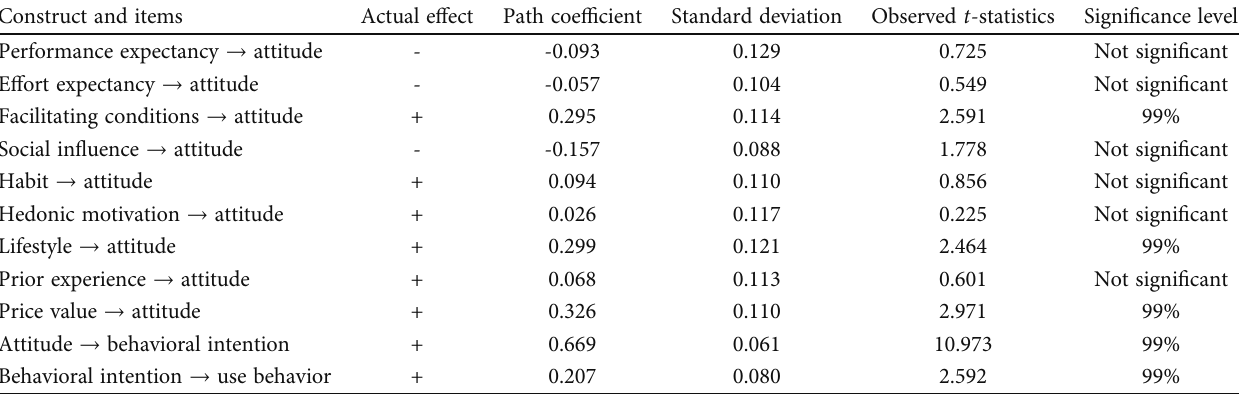
Table 9: Summary of path coe ffi cient test.